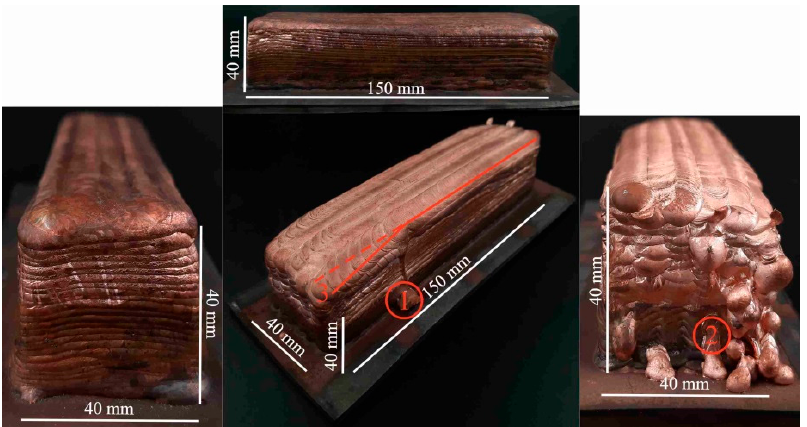
Figure 4. Macrostructure of A-type blocks fabricated using scanning strategy 2 with electron beam wire-feed additive technology. Noted defects by type: 1—droplets, 2—leaks and 3—decrease in the height.